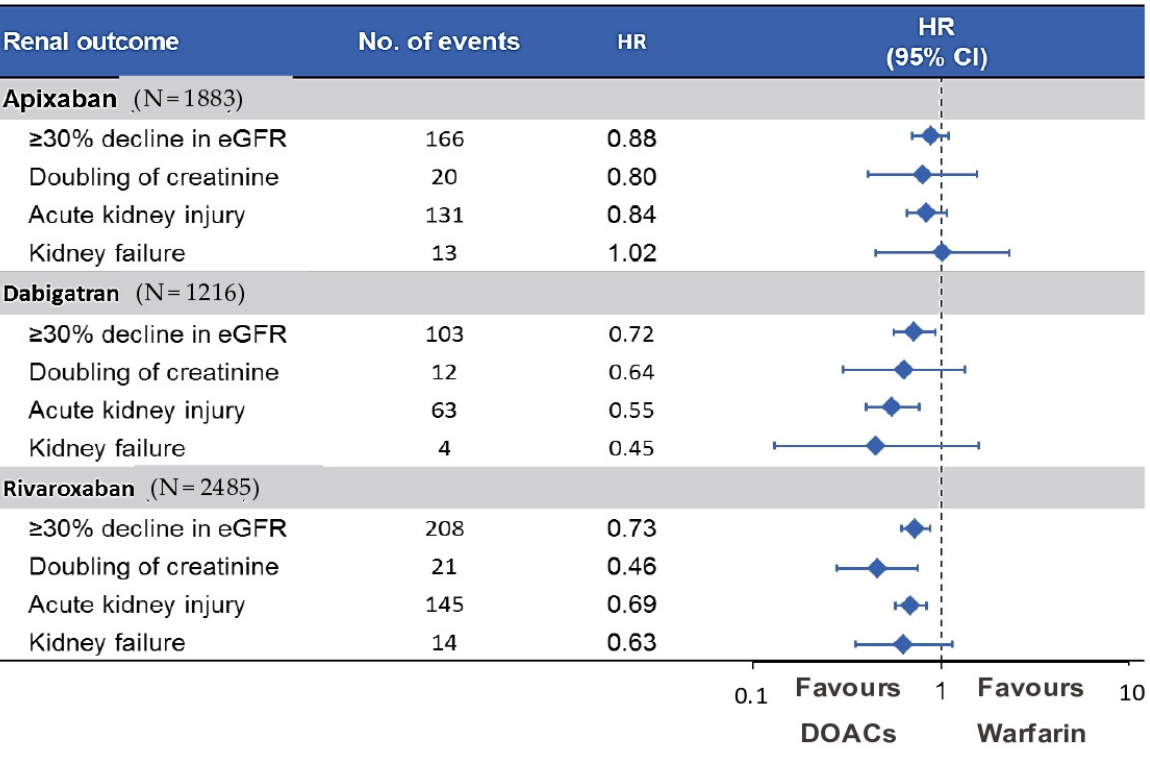
Figure 4. Comparison between direct oral anticoagulants (DOACs) and warfarin in terms of renal